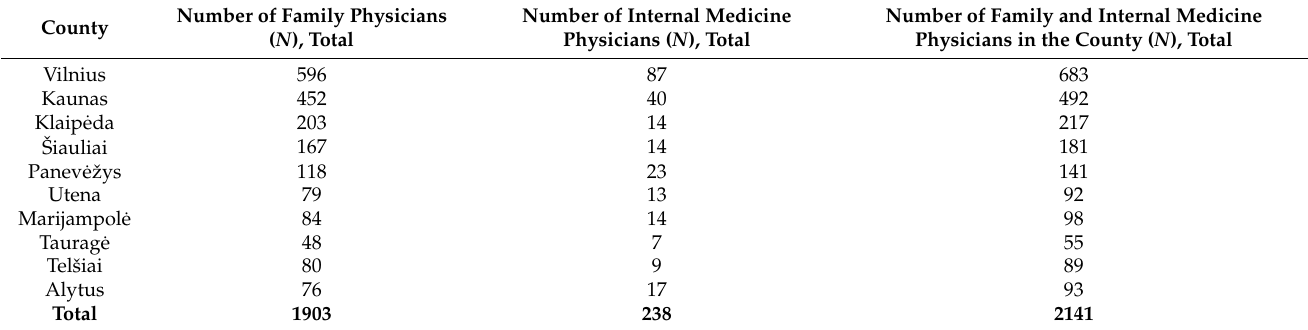
Table 1. The distribution of family physicians in Lithuanian counties.